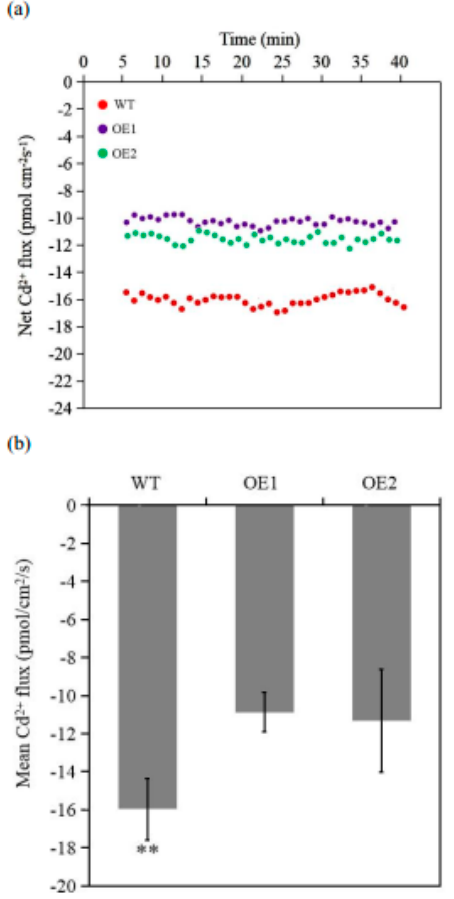
Figure 5. ( a ) Transient Cd 2+ flux of WT and transgenic wheat root tissues under Cd condition. ( b ) Average Cd 2+ flux of WT and transgenic wheat root tissues under Cd condition. ** Significant differences at p ≤ 0.01.